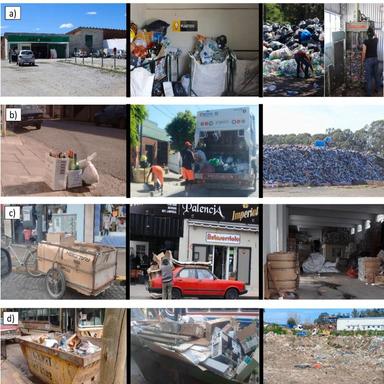
a) A municipal Clean Point, where citizens can bring some types of recycling waste (left and centre) and the manual sorting and pressing in the Taller Protegido (right). b) Initial disposal in sidewalks (left), the municipal collection and transportation service (centre) and the sanitary landfill (right). c) A waste picker self-made bike-pulled trolley for board collection in the city centre (left) and a motorized waste picker collecting board from a peripheral commercial axe (centre); at the right, an int